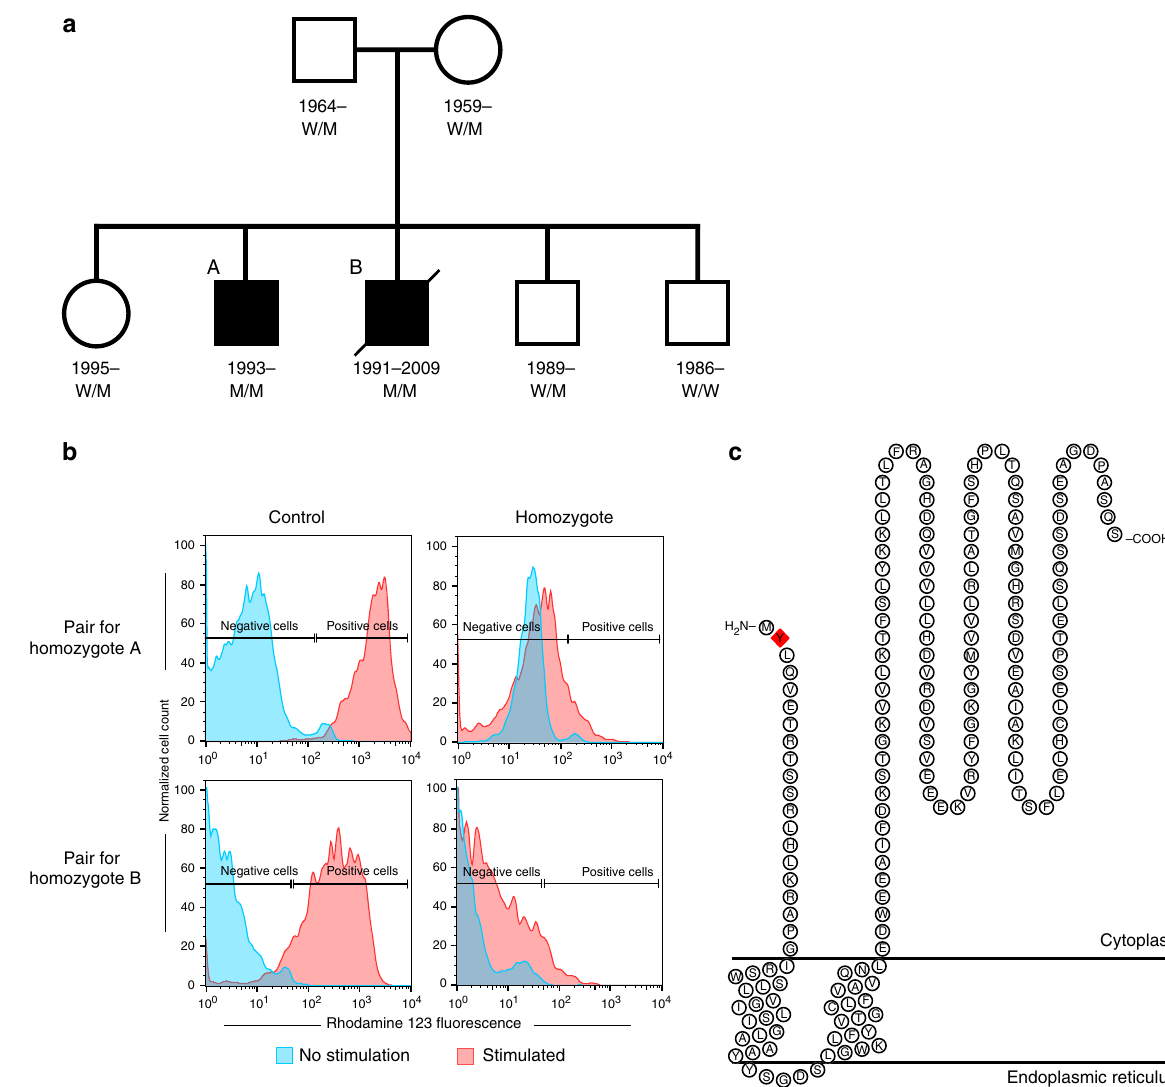
Fig. 1 Pedigree and burst test results for the two probands, and the CYBC1 protein. a Pedigree of the two CGD brothers showing their CYBC1 p.Tyr2Ter genotypes. Squares represent males, circles represent females, and a slashed symbol indicates a deceased individual. Filled symbols represent affected individuals; the two affected are referred to as individuals A and B in the manuscript. The genotype of the p.Tyr2Ter mutation (NP_001028218.1:p.Tyr2Ter; NM_001033046.3:c.6C>G; hg38 position chr17:82,449,249) is indicated with M and W, M representing the mutated allele and W the wild type. M/M therefore indicates homozygous status, W/M indicates heterozygous status and W/W a non-carrier. b Neutrophil oxidative burst test for the two CGD brothers homozygous for CYBC1 p.Tyr2Ter (individuals A and B) and their controls, test was performed pre-HSCT. Left panel shows fl uorescent peaks for unstimulated and PMA stimulated neutrophils from the controls, and the right panel shows peaks for unstimulated and PMA stimulated neutrophils from the two homozygous brothers. Negative and positive cells are de fi ned by setting a gate for unstimulated cells. Neutrophils from individuals A and B failed to generate an oxidative burst equivalent to their controls, their respective stimulation indices were SI A = 1.34 and SI B = 2.50. c Topological prediction of CYBC1 (NP_001028218.1) 28 . CYBC1 is predicted to be a transmembrane protein, spanning the lipid bilayer via two transmembrane regions (aa 21 – 39 and aa 45 – 63). A red diamond represents the p.Tyr2Ter mutation at the second amino acid of the